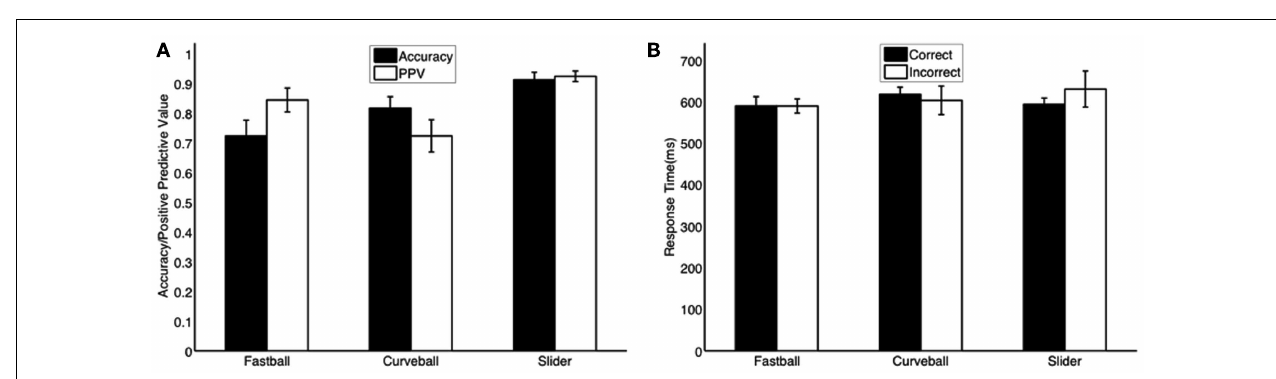
FIGURE 1 | Mean behavioral responses across subjects for (A) accuracy and positive predictive value (PPV) and (B) mean response times for correctly and incorrectly identified pitches. All bars are plotted with standard errors ( N =